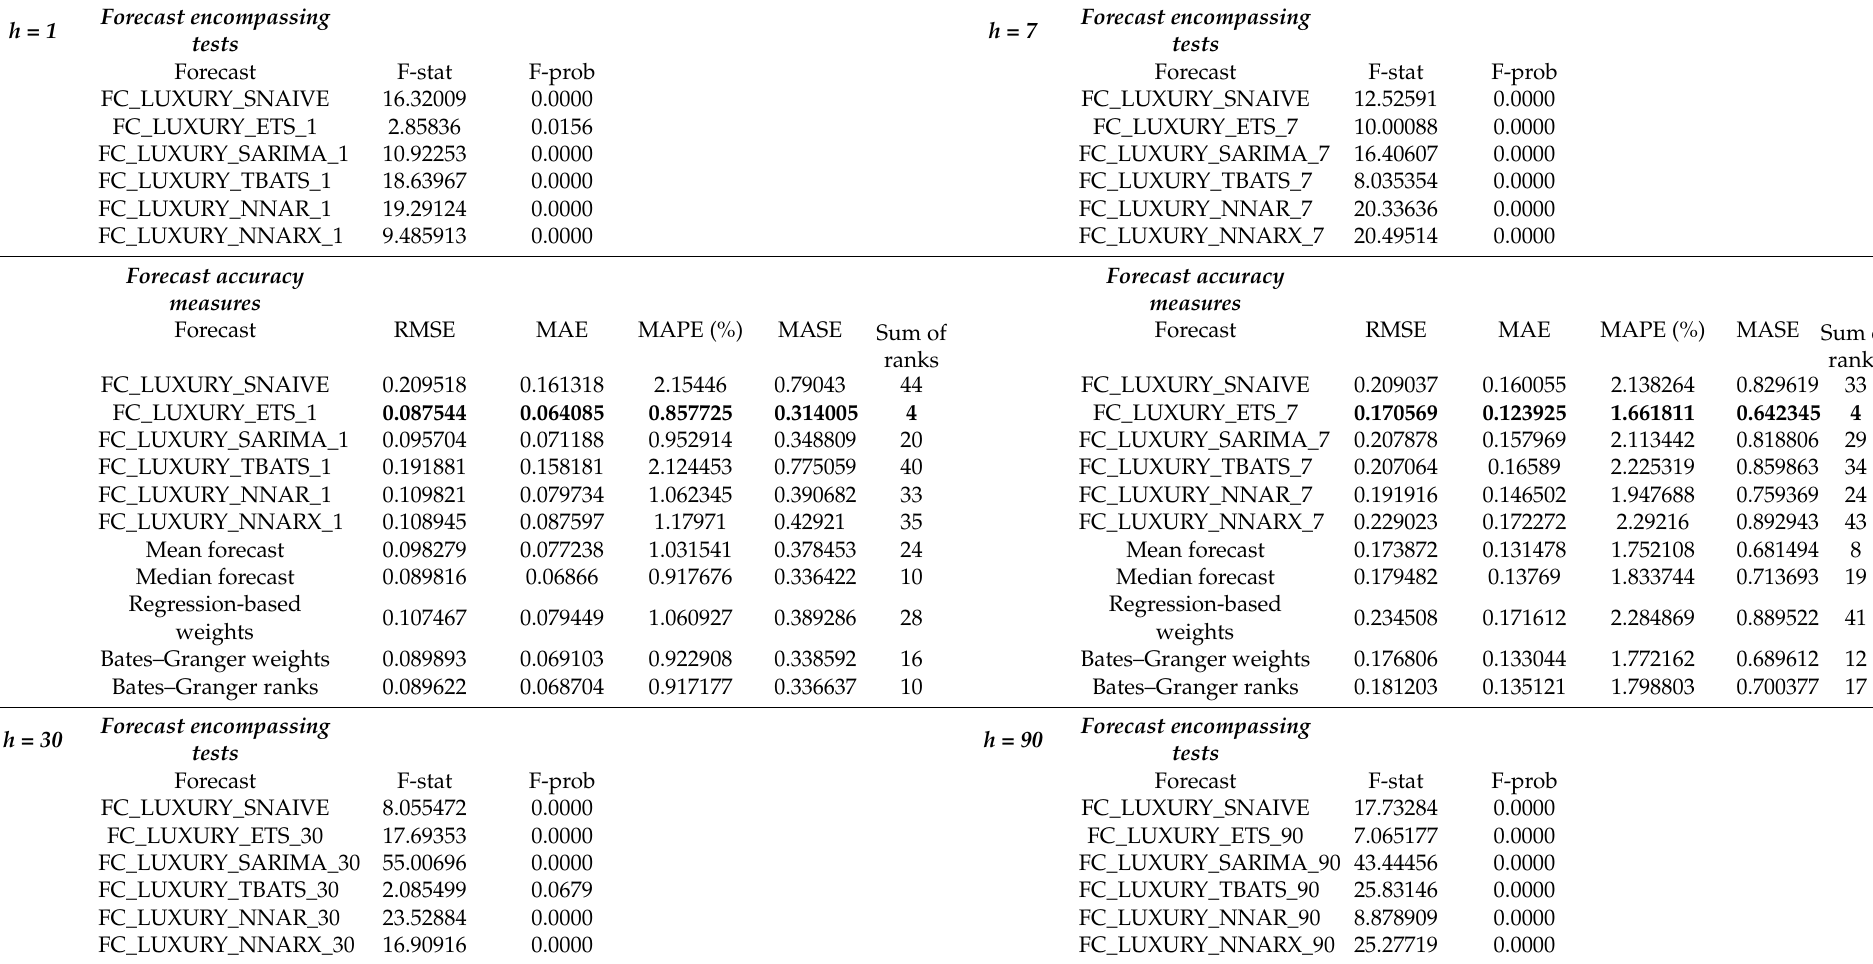
Table A1. Forecast evaluation results for the hotel class ‘luxury’. Source: STR SHARE Center, own calculations using R and